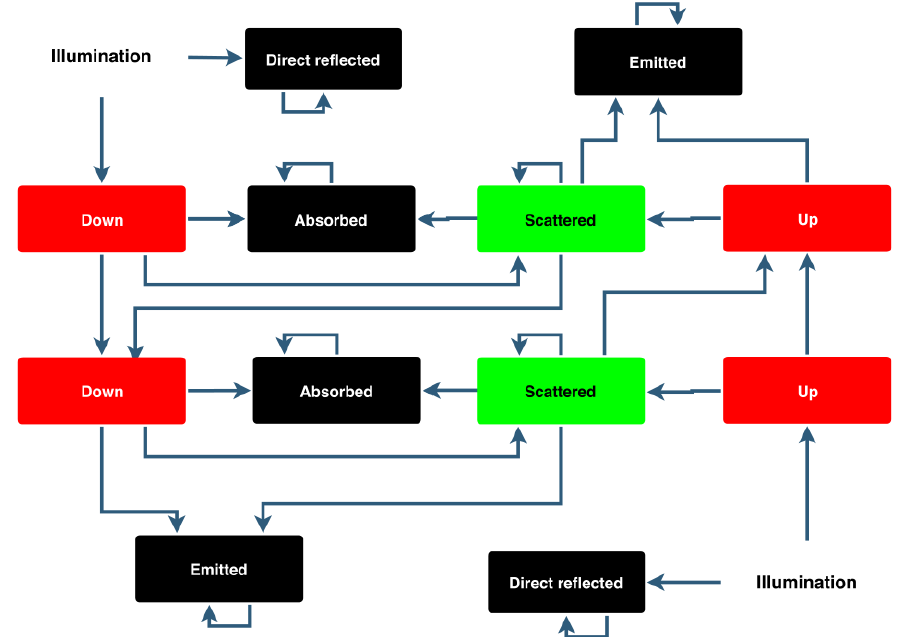
Figure 1. Diagram representation of stochastic model of leaf optical properties (SLOP). A tree leaf is assumed to have two major layers: a palisade layer and a spongy layer. In both layers, a photon can go straight through, be absorbed or scatter until it is absorbed or it moves to the previous or next layer. Adapted from [22].